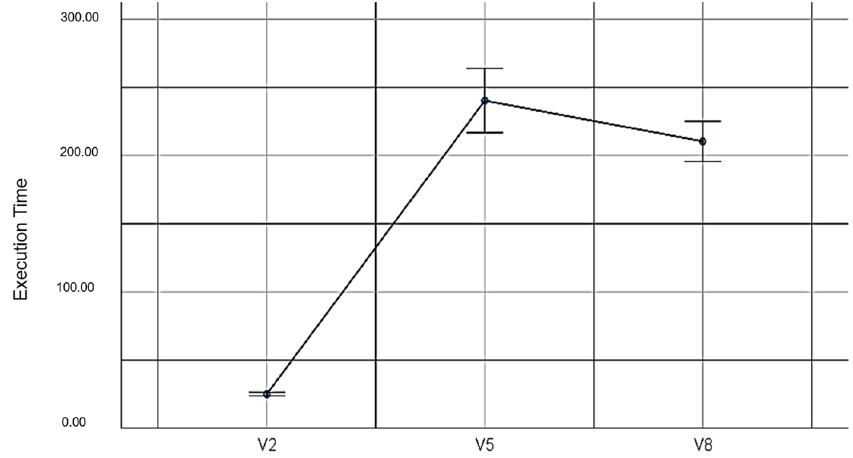
Figure 9. Execution times in the pairing cards experiment. When comparing the numbers of errors in the pairing cards experiment, no statistically significant differences were found among the three experimental conditions ( F (2, 78) = 0.24, p = 0.79, η 2 = 0.006). These results support the third hypothesis. Table 6 shows the descriptive values of the number of errors made in the experiment. Table 6. Descriptive values of the number of errors made in the pairing cards experiment.